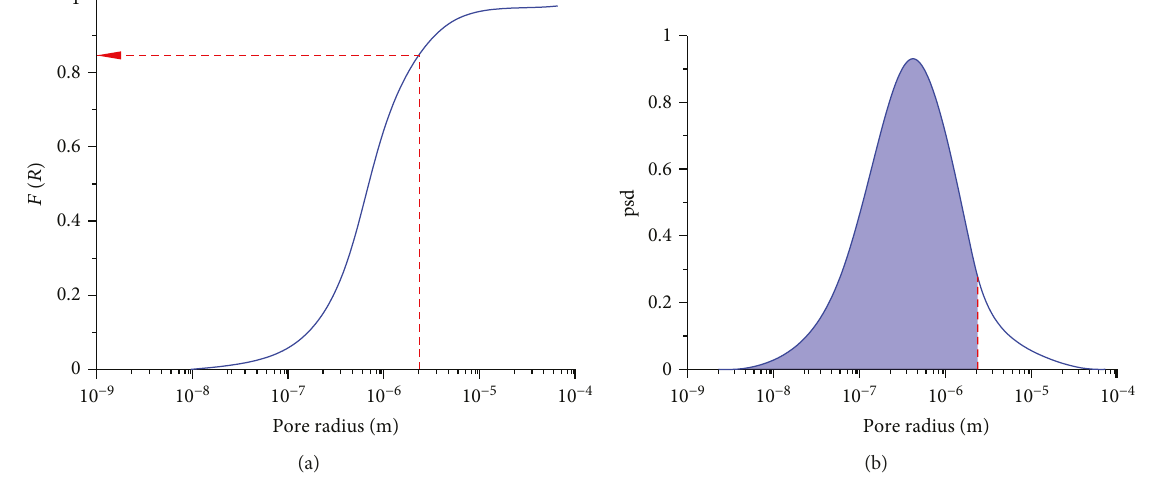
Figure 1: Typical diagram of pore